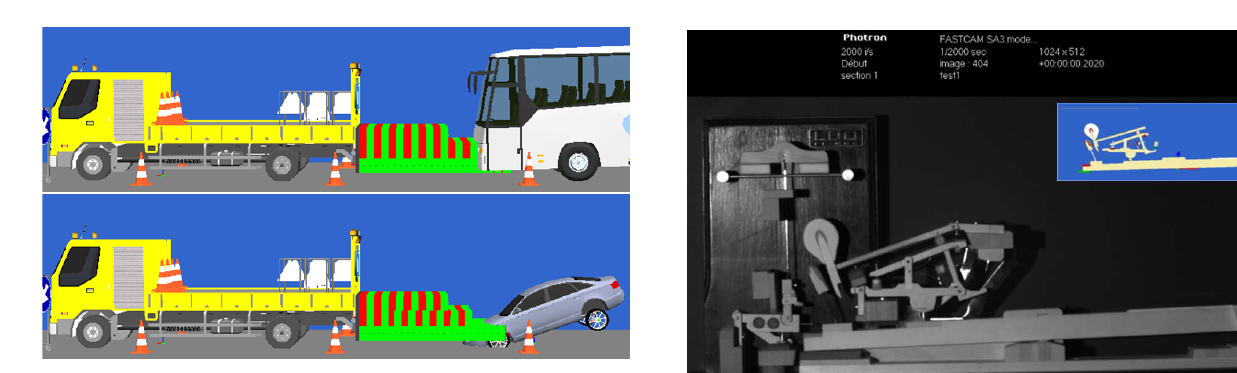
Figure 19. Influence of the number of bodies used to discretize a TMA block and comparison with experimental results.